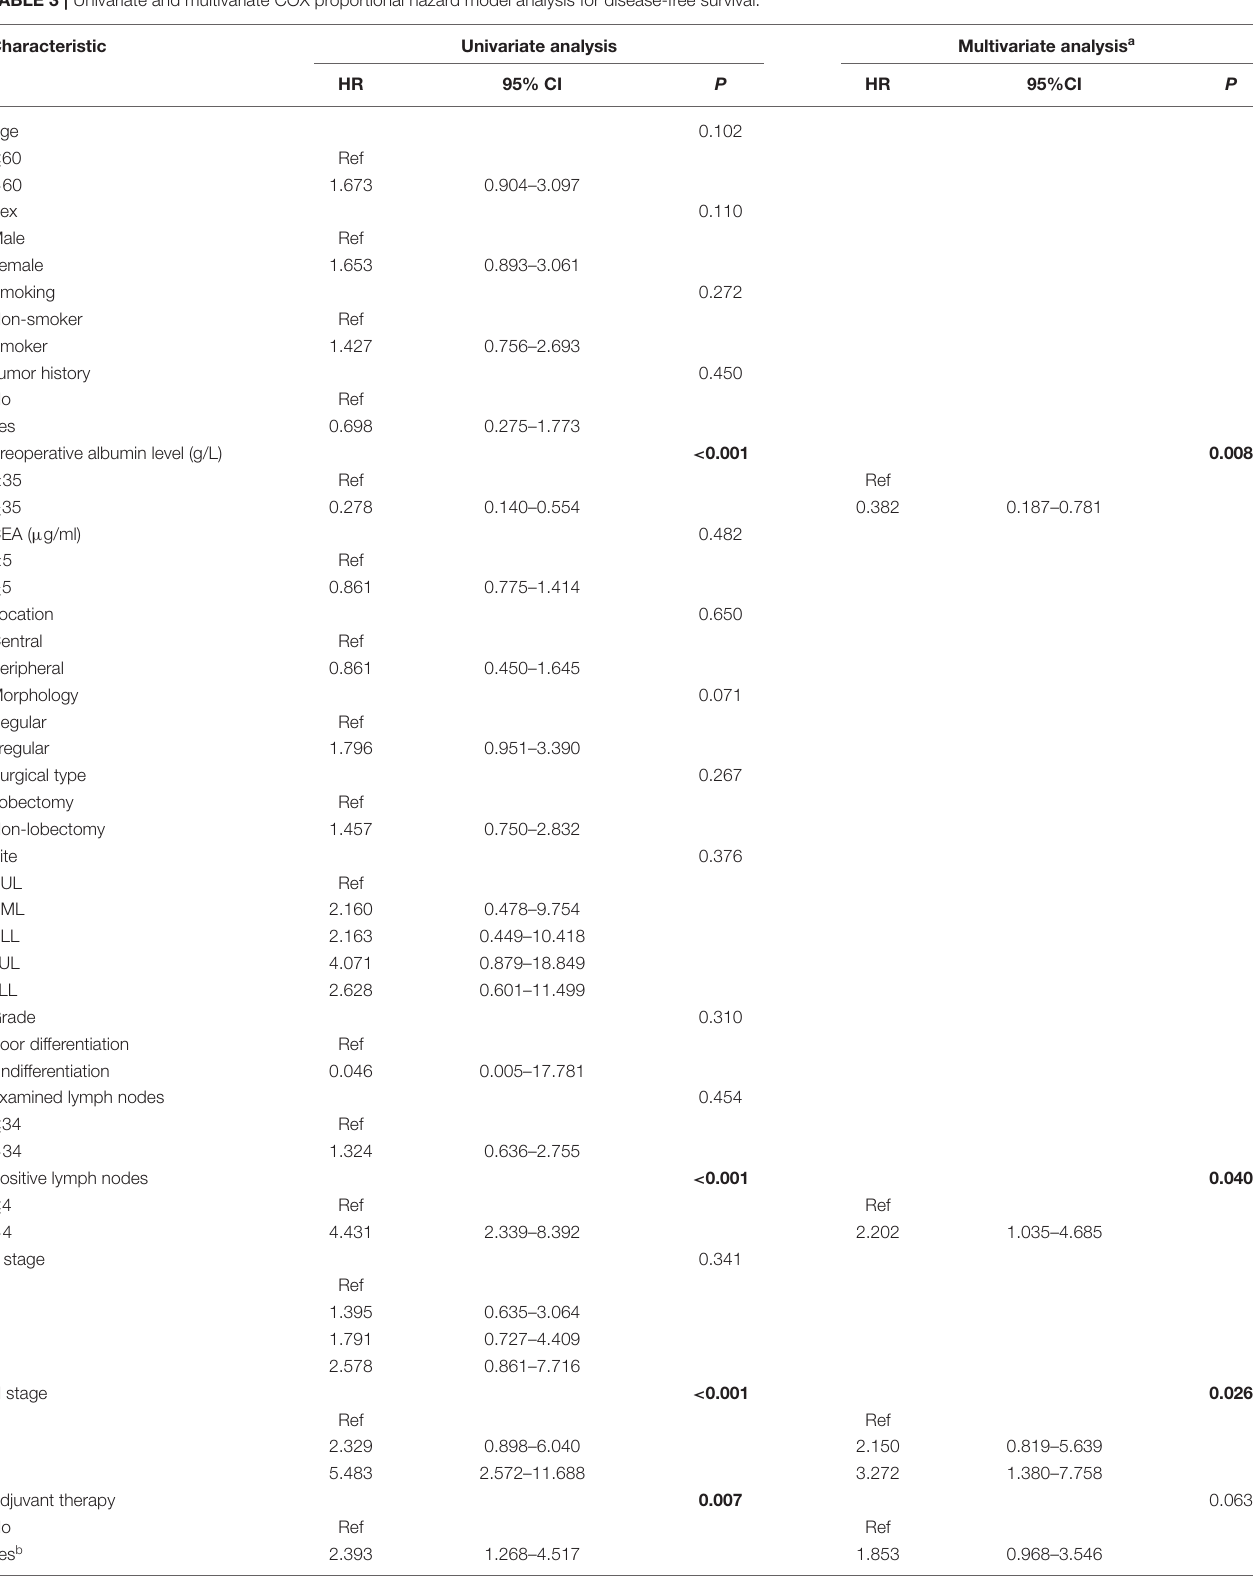
TABLE 3 | Univariate and multivariate COX proportional hazard model analysis for disease-free survival. Characteristic Univariate analysis Multivariate analysis